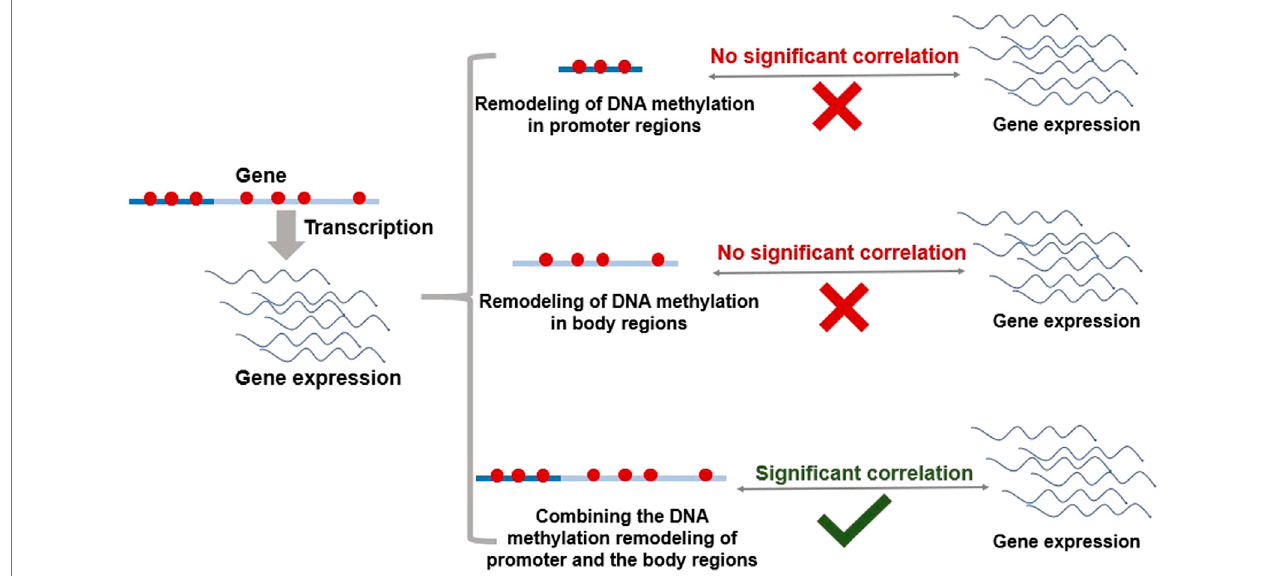
FIGURE1| CorrelationsofDNAmethylationremodelinginpromoterand bodyregionswithgeneexpression.Darkblue linesrepresent thepromoterregionsofthe gene, and light blue lines represent the body regions of the gene. Red dots represent DNA methylation sites on the genome.